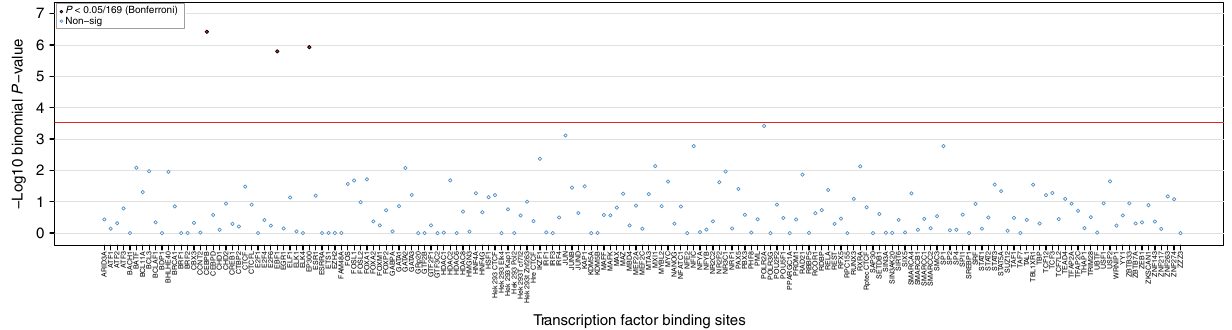
Fig. 4 Enrichment analysis of CpGs signi fi cantly associated with eGFR for mapping into regions containing speci fi c transcription factor binding sites. Y -axis: -log 10 ( P -value) from a binomial test comparing the expected and observed numbers of signi fi cant CpGs that map into the binding site regions for a given transcription factor. X -axis: 169 evaluated transcription factors, listed in alphabetical order. Across 169 evaluated transcription factors, CpGs associated with eGFR at P < 1e-05 in the meta-analysis of ARIC and FHS show signi fi cantly enriched mapping into regions that contain binding sites for transcription factors CEBPB, EBF1, and EP300 (red color). Enrichment testing was carried out using permutation with matching for genomic localization when sampling from the background. Statistical signi fi cance was set at P < 3e-04 (red line), corresponding to a Bonferroni correction for 169 transcription